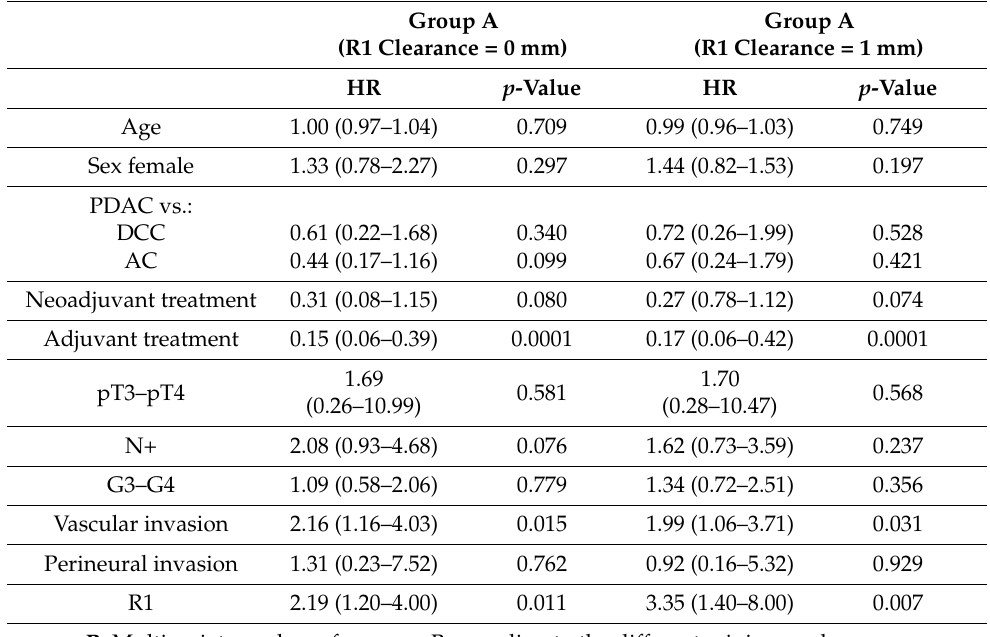
Table 4. Multivariate analysis of prognostic factors according to method of pathological evaluation and minimum